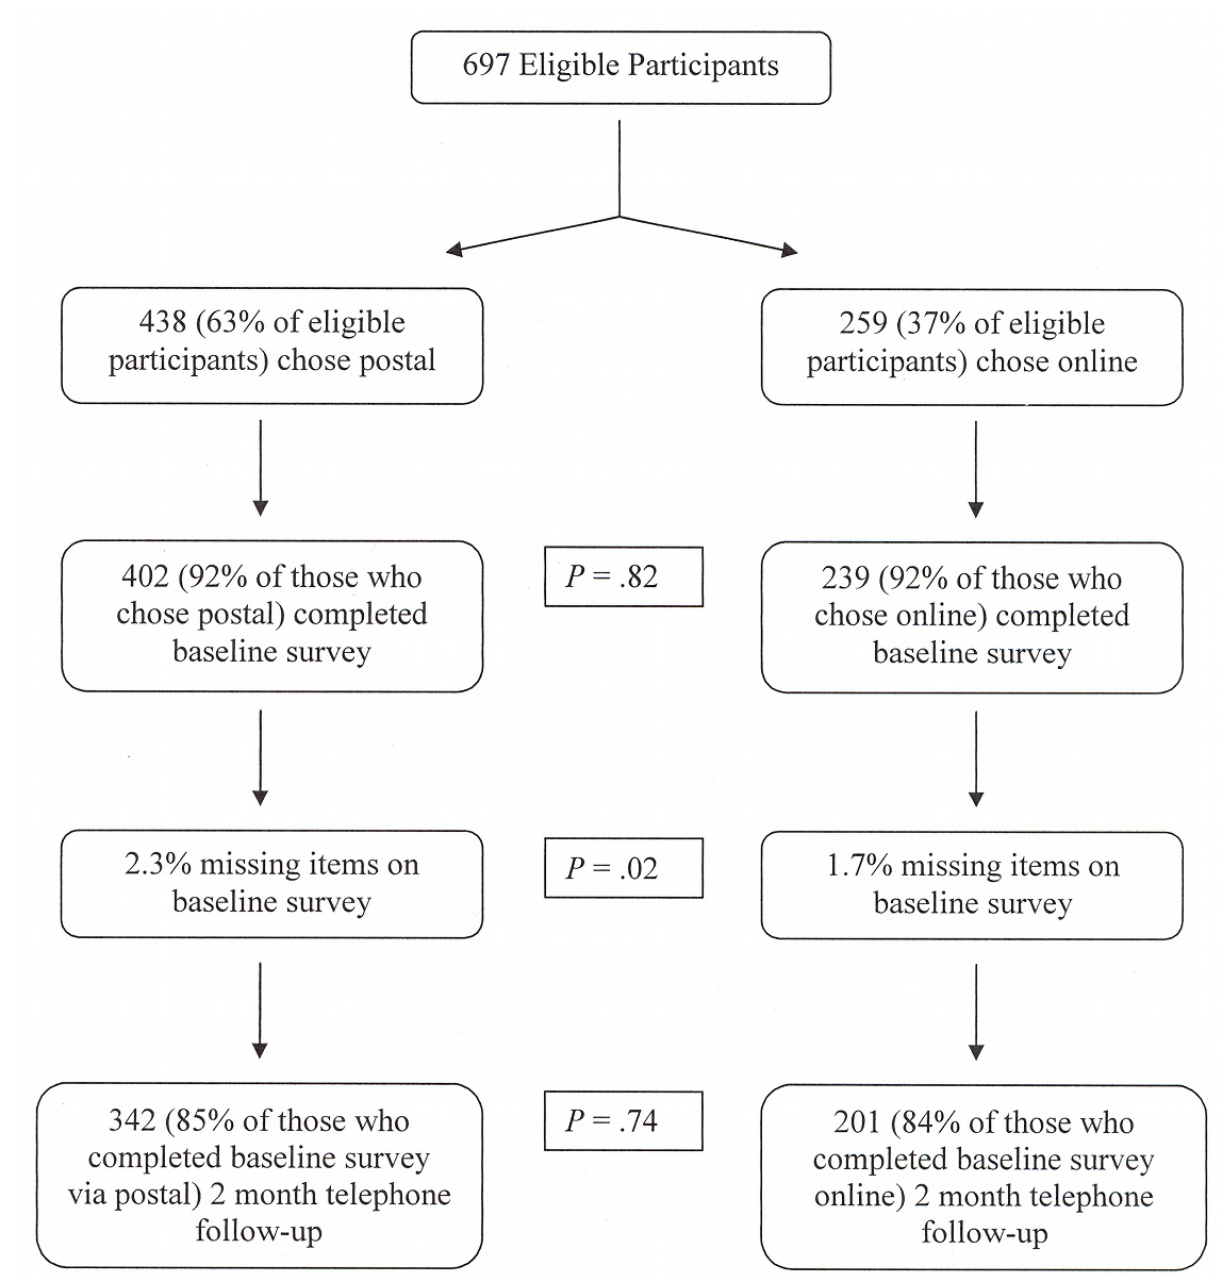
Figure 1. Choice of response mode, response rates, and rates of missing